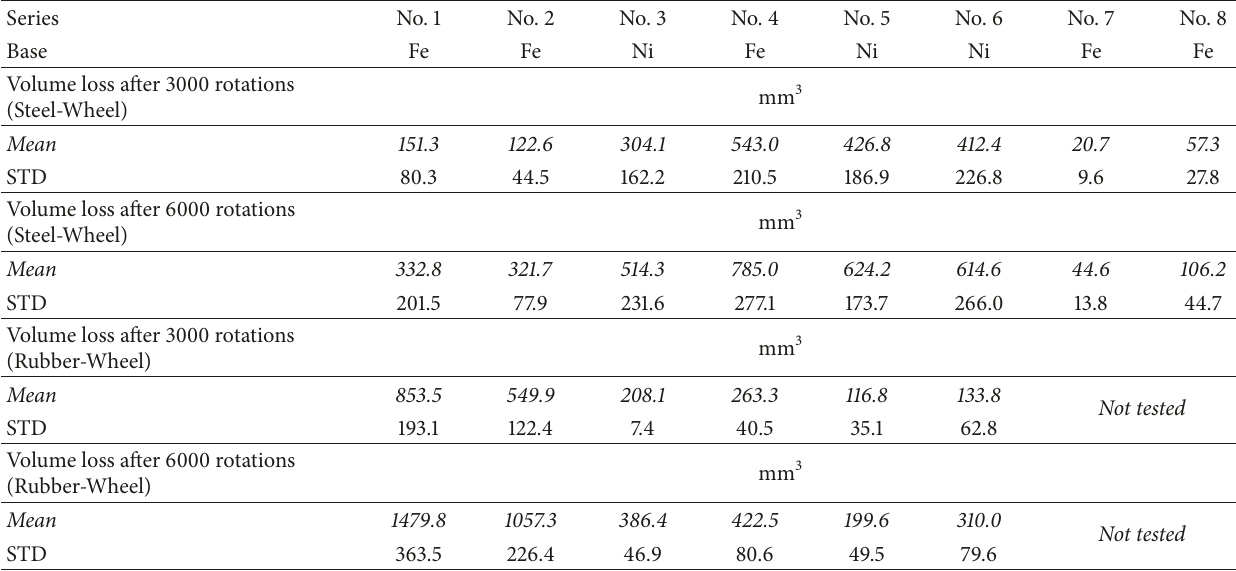
Table 5: Results from tribometry, in mm 3 volume